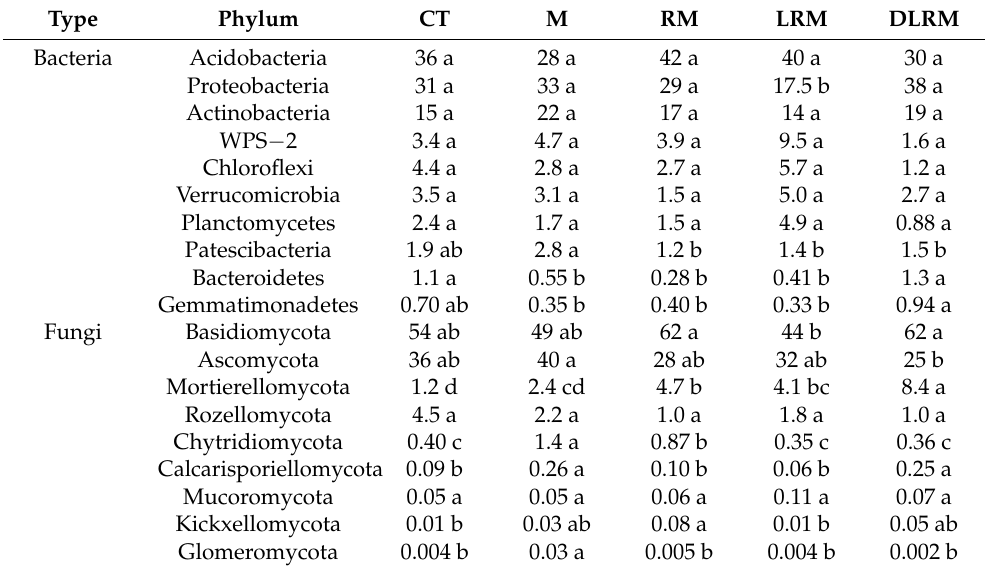
The data in the table are mean values (n = 3), and different lowercase letters indicate significant difference among treatments ( p < 0.05).